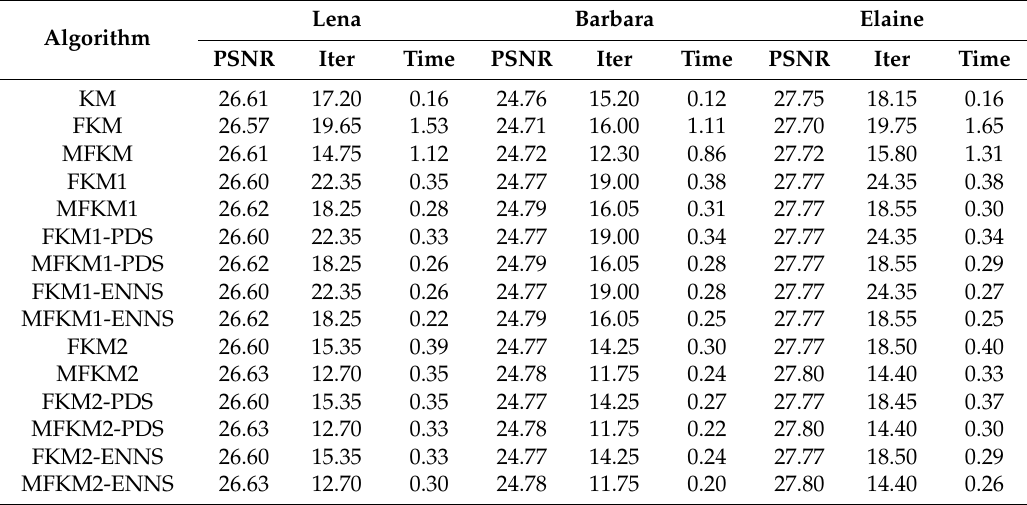
Table 2. PSNR (in dB), number of iterations and codebook design time (in seconds) for images Lena, Barbara and Elaine, using N =